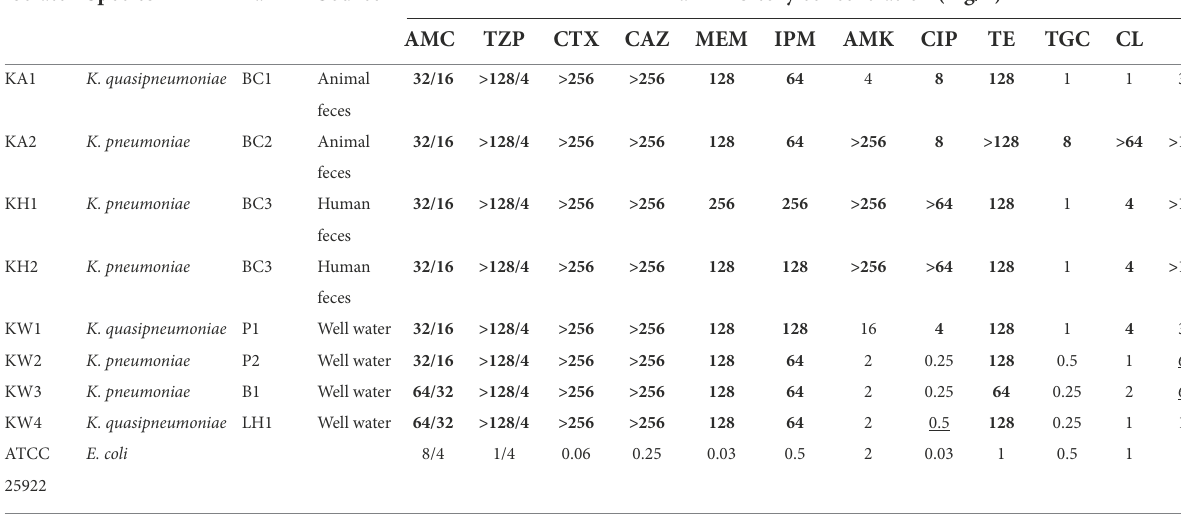
TABLE 1 Antimicrobial susceptibility profiles of carbapenem-resistant Klebsiella spp . strains from animal farms in Shandong, China. Isolate